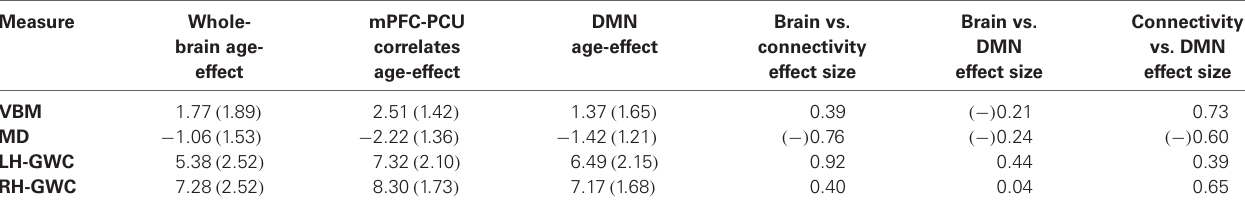
Table 5 | Mean effect of age and effect sizes comparisons between brain mask, mPFC-PCU correlates mask and DMN mask . Measure Whole- mPFC-PCU DMN Brain